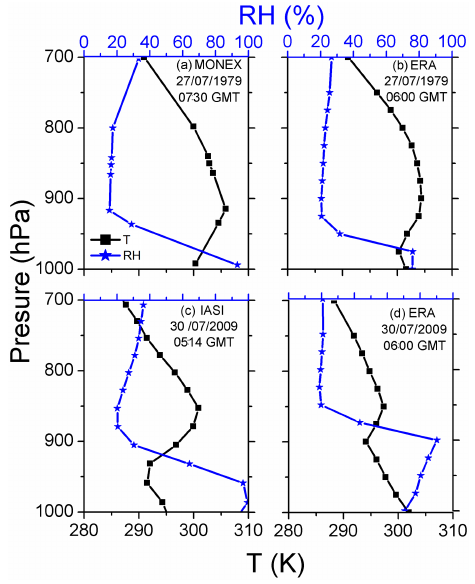
Figure 1. Typical examples showing MI in T and RH on (a) 27 June 1979 at 07:30GMT at 20 ◦ N, 60 ◦ E measured by radiosonde during MONEX experiment, (b) same as panel (a) but at 06:00GMT from ERA-Interim (ERA), (c) 30 July 2009 at 05:14GMT at 22 ◦ N, 68 ◦ E by IASI, (d) 30 July 2009 by ERA-Interim at same location but at 06:00GMT. Note that scale for RH is shown in the top axis of panels (a) and (b)